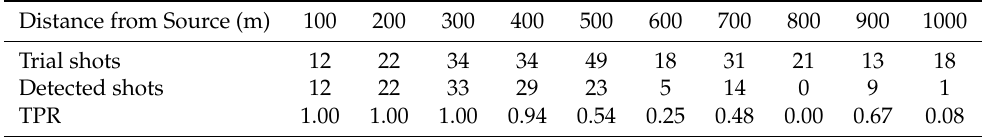
Table 1. Detection counts and true-positive rates from shots fired at increasing distances from the AudioMoth deployment location. These sites varied in terms a wide variety of variables including terrain, wind direction, and foliage thickness, resulting in an array of detection accuracies at distances greater than 500